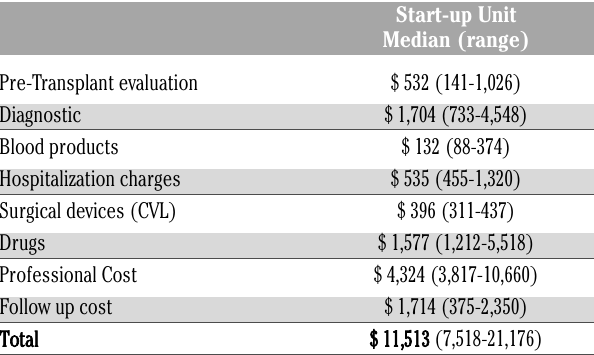
Table 4. Cost comparison. Pakistan costs obtained from the seven transplants performed in the start-up unit in a government hos- pital, all patients had at least 8 months follow up